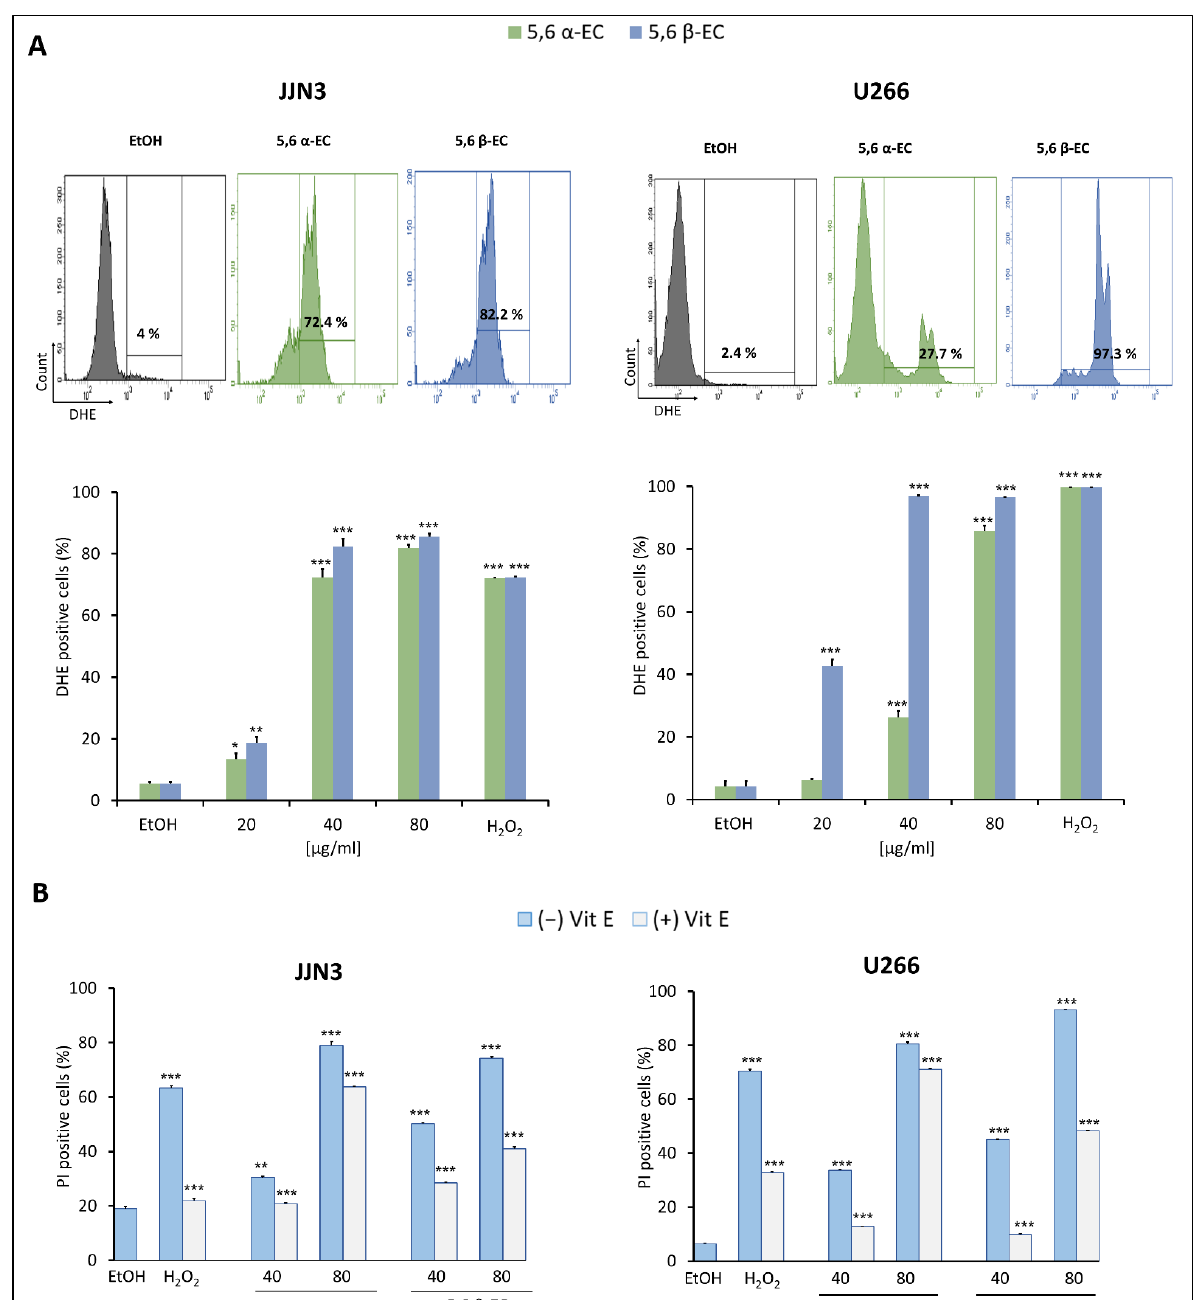
Figure 4. ROS overproduction induced cell death of 5,6 ECs-treated HMCLs. (A) JJN3 and U266 cells were cultured in 24-well plates (2 × 10 5 cells/well) for 24 h. Then, cells were treated with 20-80 µg/mL of 5,6 α -EC or 5,6 β -EC for 24 h or with 500 µM H 2 O 2 used as a positive control. ROS overproduction was evaluated by flow cytometry (upper part). The percentages of DHE+ cells (overproducing superoxide anion O 2- ) are indicated by the histograms (lower part). ( B ) Cells were treated or not with 400 µM Vit E for 2 h then, treated for 24 h with 5,6 α -EC or 5,6 β -EC (40–80 µg/mL). The inhibition of death induced by 5,6-ECs was evaluated by the percentage of PI+ HMCLs presented as means ±SD . Statistical t -tests were used to calculate the p -values between 5,6 α / β -ECs-treated cells vs. vehicle-treated cells or between 5,6 α / β -ECs- vs. 5,6 α / β -ECs + Vit E-treated cells (* p < 0.05; ** p < 0.01; *** p < 0.001) (Table S8). No statistically significant difference between control and vehicle (EtOH) was noticed.